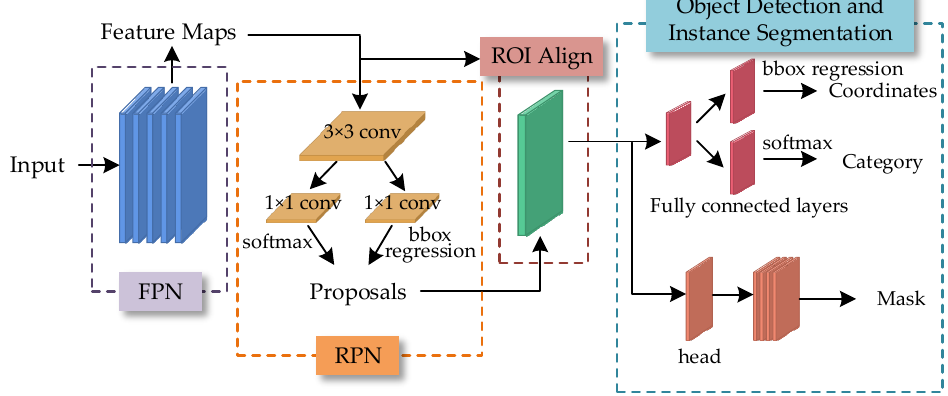
Figure 1. Network structure of catenary insulator identification based on Mask R-CNN.